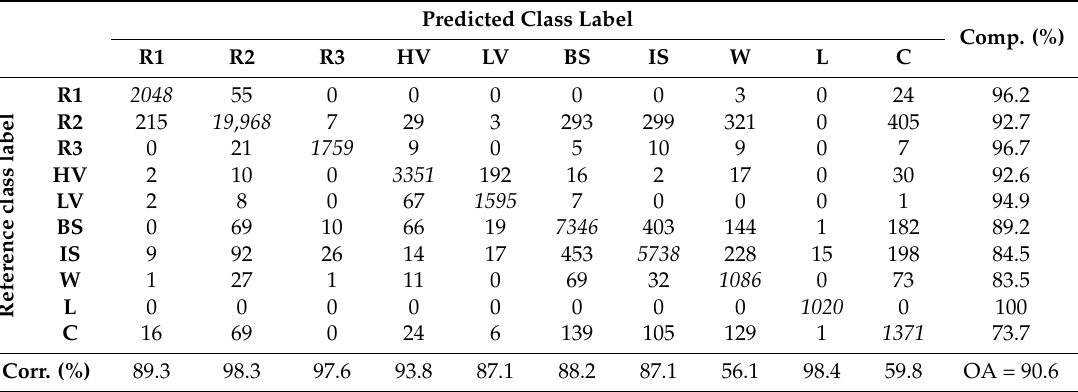
Table 6. Error matrix of the HSIC-f 45 CSMKSVM method; numbers indicate the total number of pixels over the 10 folds. The final column provides the completeness (Comp.) of each class, and the final row provides the correctness (Corr.). R1, R2 and R3 correspond to 3 types of roof materials; HV = high vegetation, LV = low vegetation, BS = bare surface, IS = impervious surface, W = wall structures, L = lamp posts, C =